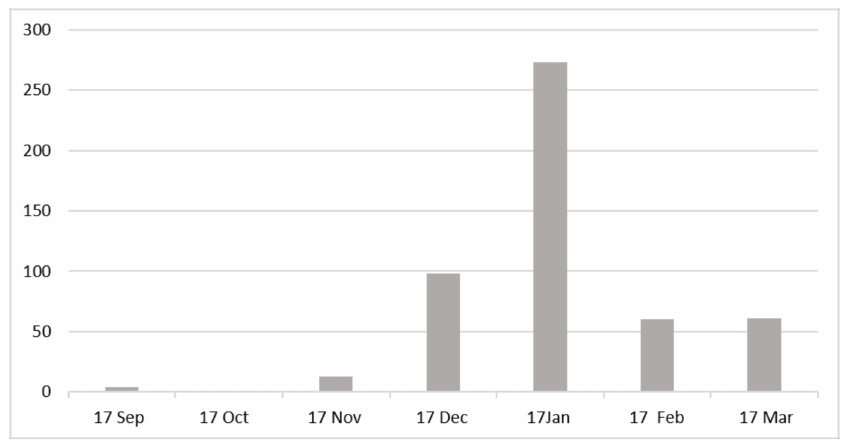
Figure 3. Number of A&E breaches by month.